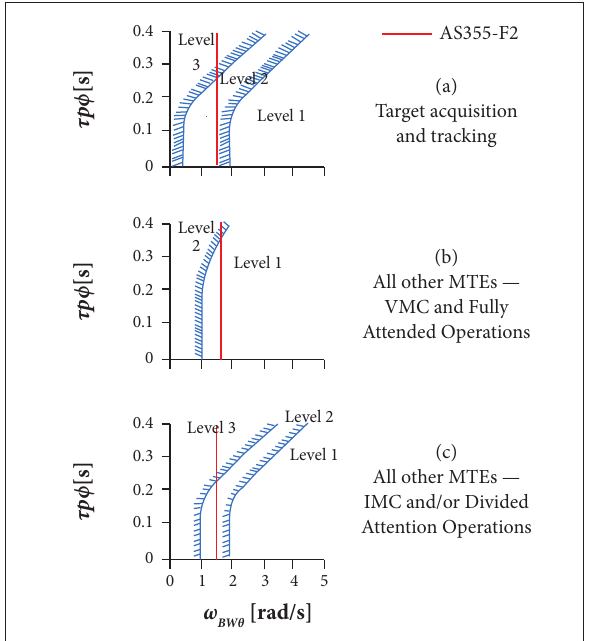
Figure 14. Flying qualities levels – AS355-F2 longitudinal response (ADS-33E-PRF 2000).